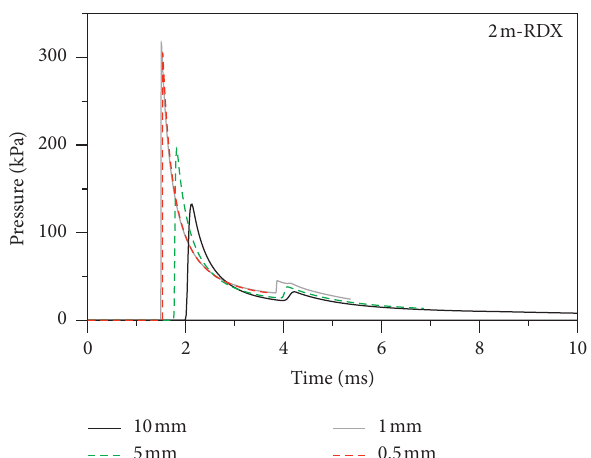
Figure 7: Numerically predicted pressure histories for the RDX explosive, as measured from gauge #2, as a function of the mesh size.